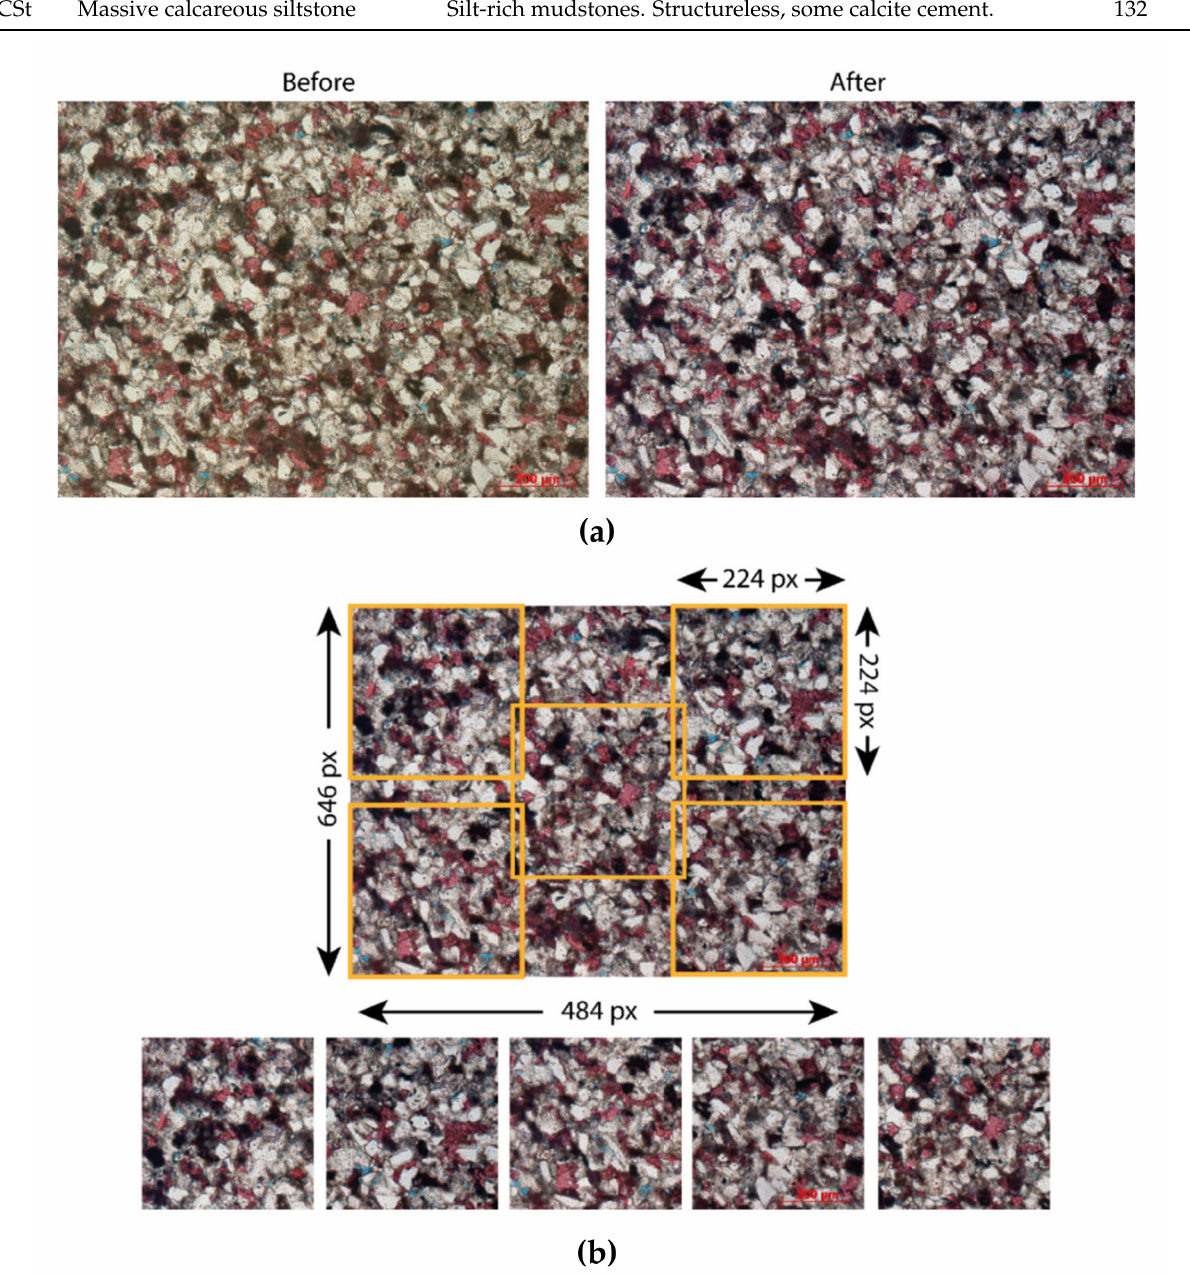
Figure 1. Thin-section data: ( a ) color balancing effect;( b ) five-crop technique. The bottom row shows each one of the five crops extracted from the original sample and used for training and